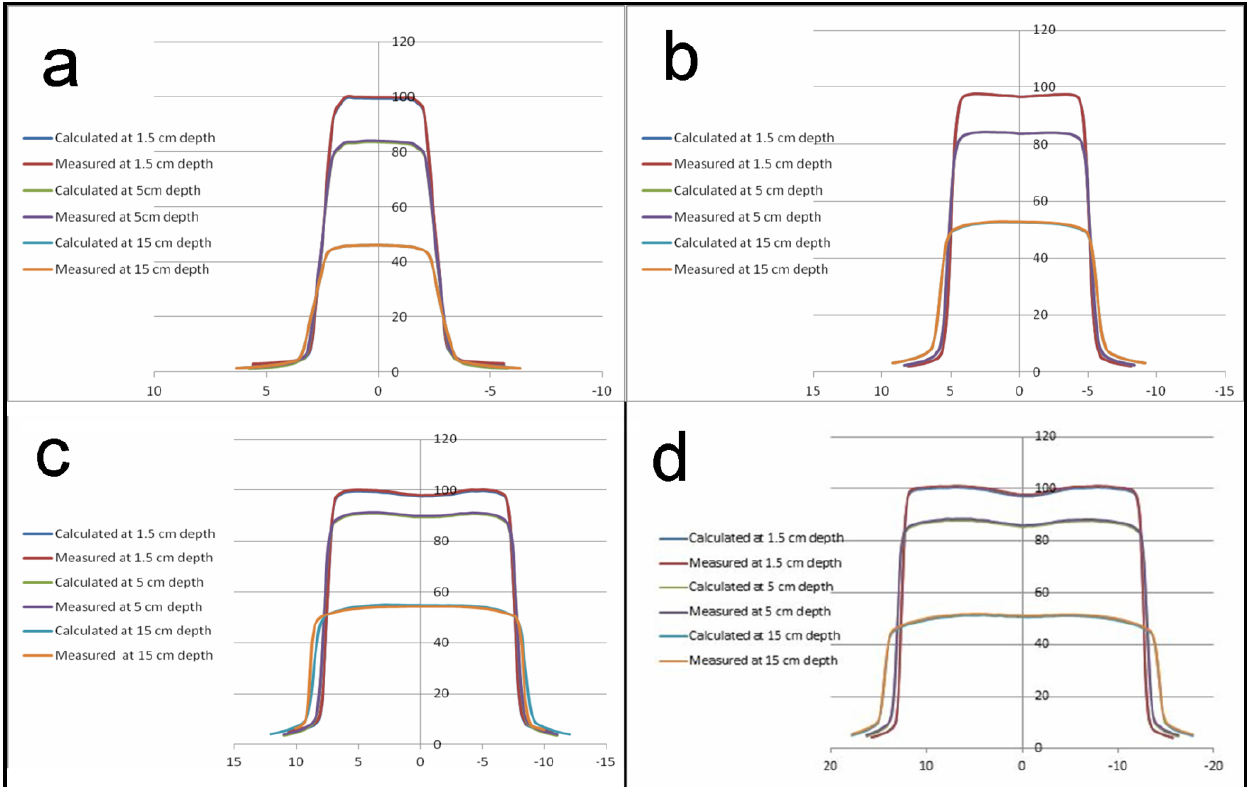
Figure 2. Measured and calculated profiles for field sizes : a) 5x5cm 2 at SSD =100 cm, b) 10x10cm 2 at SSD =100 cm, c) 15x15cm 2 at SSD =100 cm and d) 25x25cm 2 at SSD =100